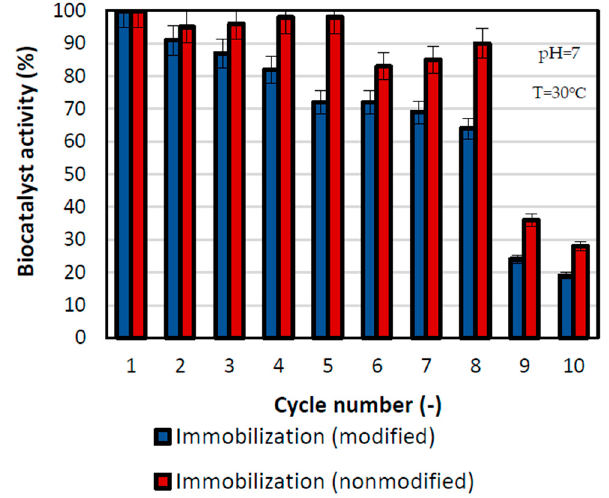
Figure 5. Reusability of the biocatalyst obtained by physical immobilization by the adsorption interactions and partially interfacial activation and mixed physical immobilization via interfacial activation and ion exchange. All experiments were performed in duplicate and the results presented in each of the graphs are presented as a mean value, for which standard deviation (error value) does not exceed 5%. The reusability tests were performed in the temperature of 30 °C and in phosphate buffer at pH 7.